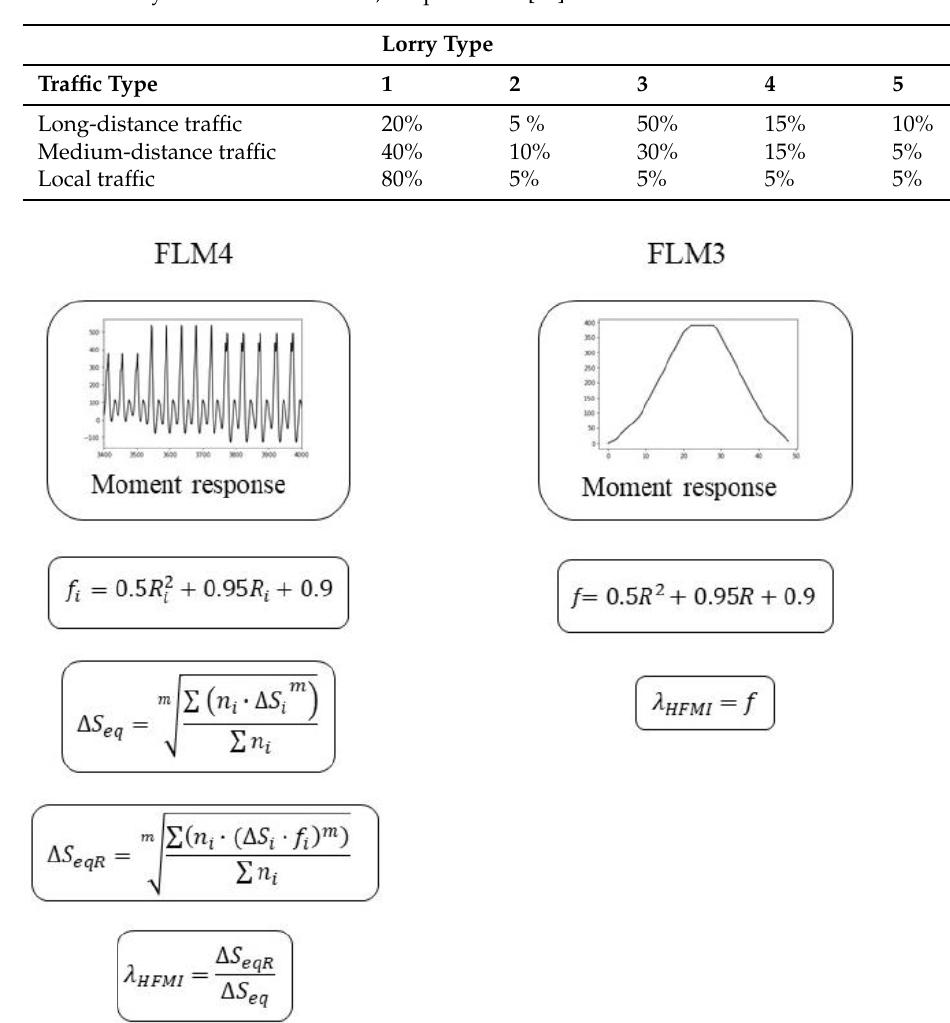
Figure 9. Lorry types in FLM4, adapted from [14]. Table 2. Lorry distribution in FLM4, adapted from [14].